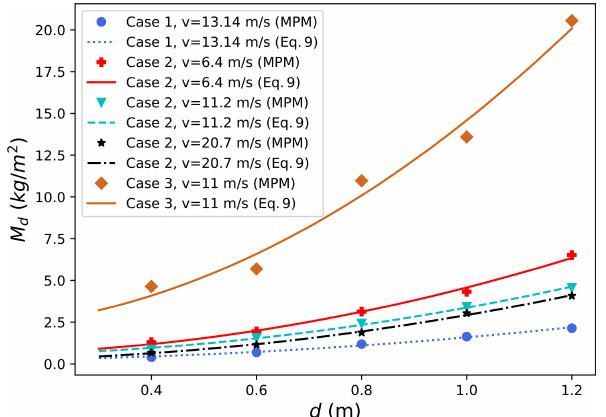
Figure 8. Evolution of the detrainment mass per unit of area with the tree diameter for different types of snow and front velocity (reg- ular staggered forest, e =